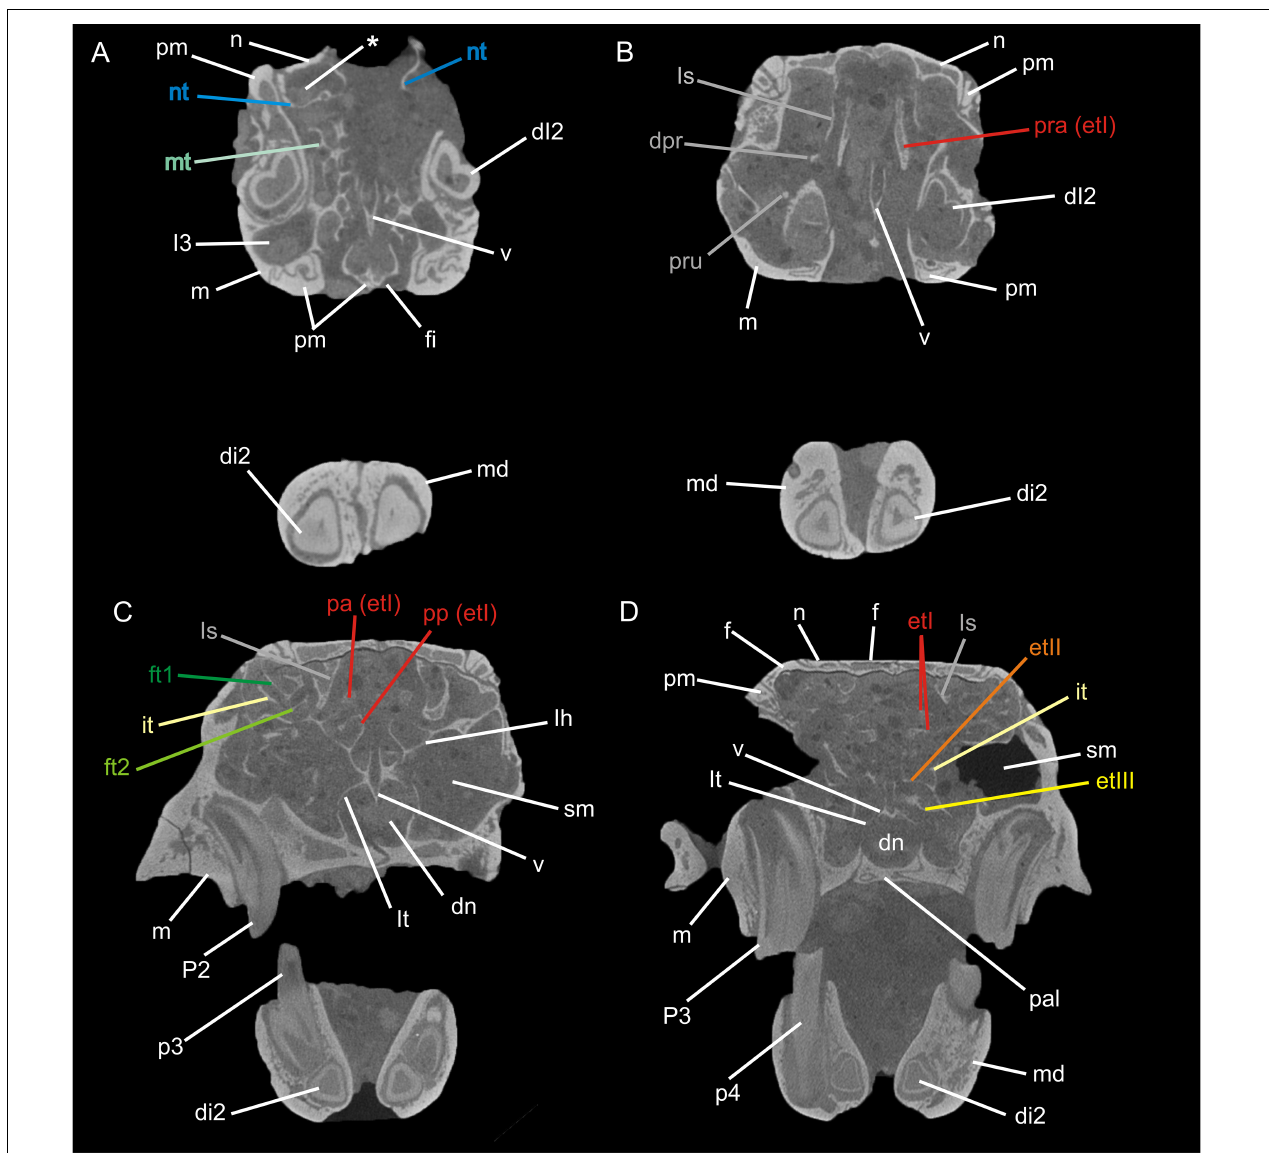
FIGURE 2 | Transversal µ CT images through the nasal cavity of Palaeolagus haydeni (FMNH PM9476) from anterior (A) to posterior (D) . The asterisk (*) indicates the cavity formed by the nasoturbinal and the nasal. Abbreviations: dI2, deciduous upper incisor 2; di2, deciduous lower incisor 2; dn, ductus nasopharyngeus; dpr, dorsal process; et I-III, ethmoturbinal I–III; ft1-2, frontoturbinal 1–2; f, frontal; fi, foramen incisivum; I3, upper incisor 3; it, interturbinal; lh, lamina horizontalis; ls, lamina semicircularis; lt, lamina terminalis; m, maxilla; md mandible; mt, maxilloturbinal; n, nasal; nt, nasoturbinal; p3–4, lower premolars 3 and 4; P2–3, upper premolars 2 and 3; pa, pars anterior; pal, palatine; pm, premaxilla; pp, pars posterior; pra, processus anterior; pru, processus uncinatus; sm, sinus maxillaris; v, vomer. Not to